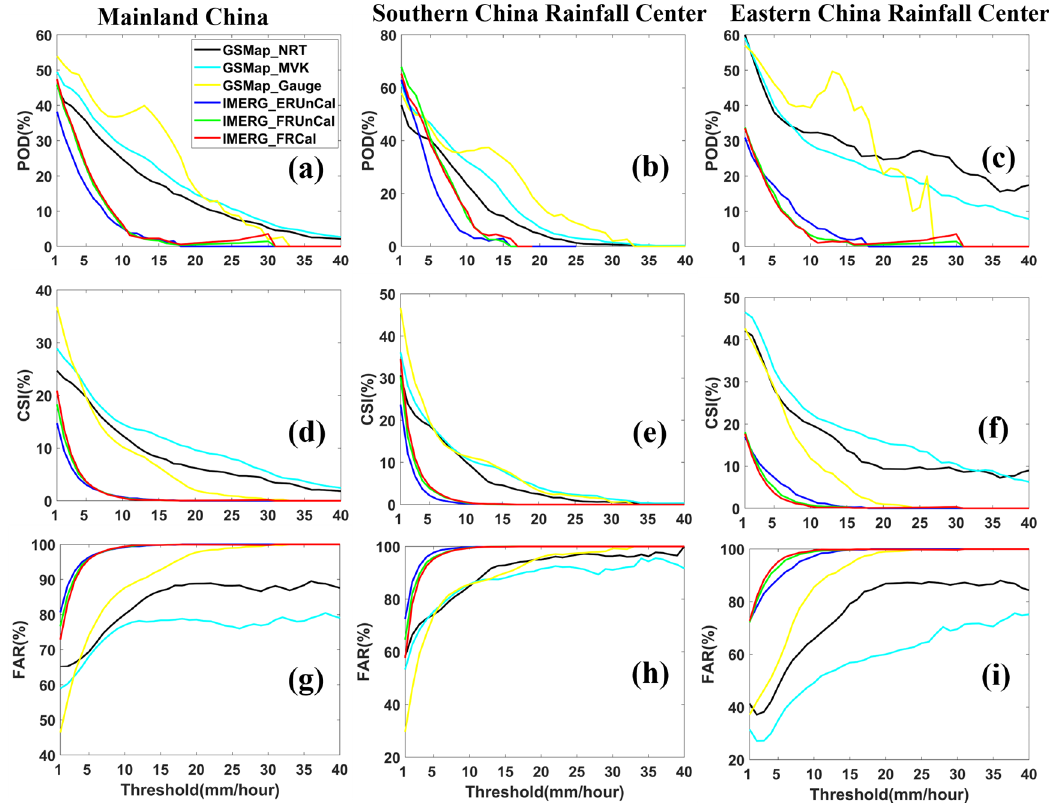
Figure 5. Contingency statistics computed from the Global Satellite Mapping of Precipitation (GSMaP) and Integrated Multi-satellitE Retrievals for Global Precipitation Measurement (IMERG) hourly precipitation products over mainland China and two rainfall centers: ( a – c ) Probability of Detection (POD), ( d – f ) Critical Success Index (CSI), and ( g – i ) False Alarm Ratio (FAR).